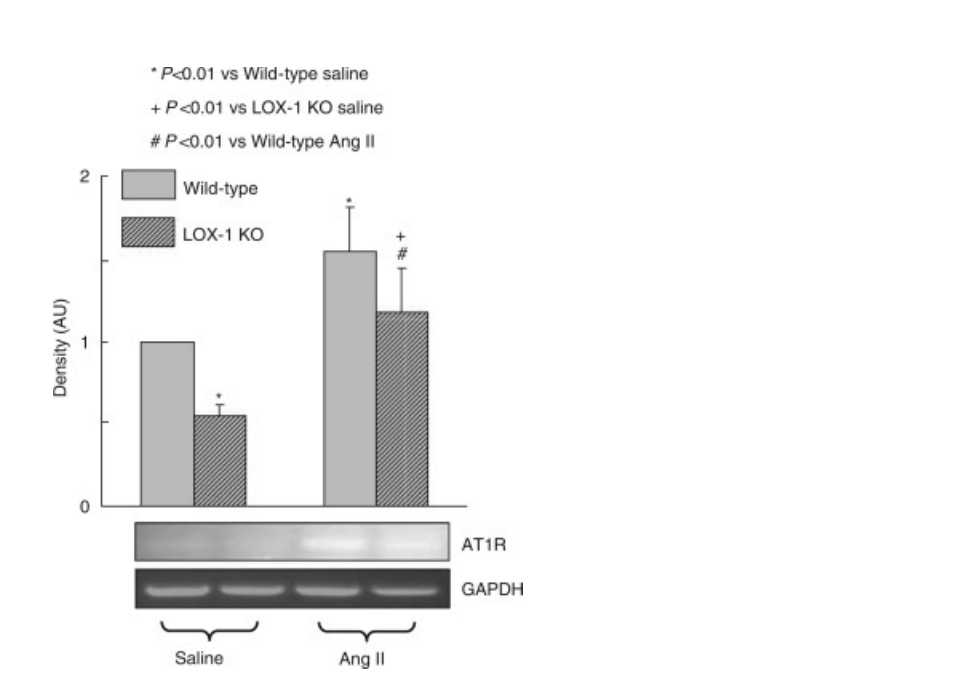
Figure 2. Expression of AT1R. Ang II-infused LOX-1 knockout mice showed less increase in the expression of AT1R ( n = 5). AT1Rs: angiotensin type 1 receptors. Reproduced with permission from [58].